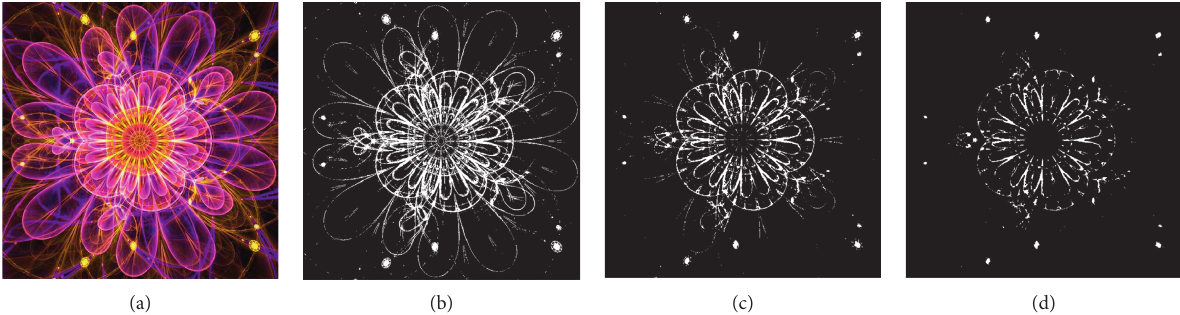
Figure 6: Comparison of Newton iteration graphs after corrosion calculation of different structural elements. (a) Original image. (b) Binary image after dither processing. (c) Corrosion of diamond structural element. (d) Corrosion of square structural element.